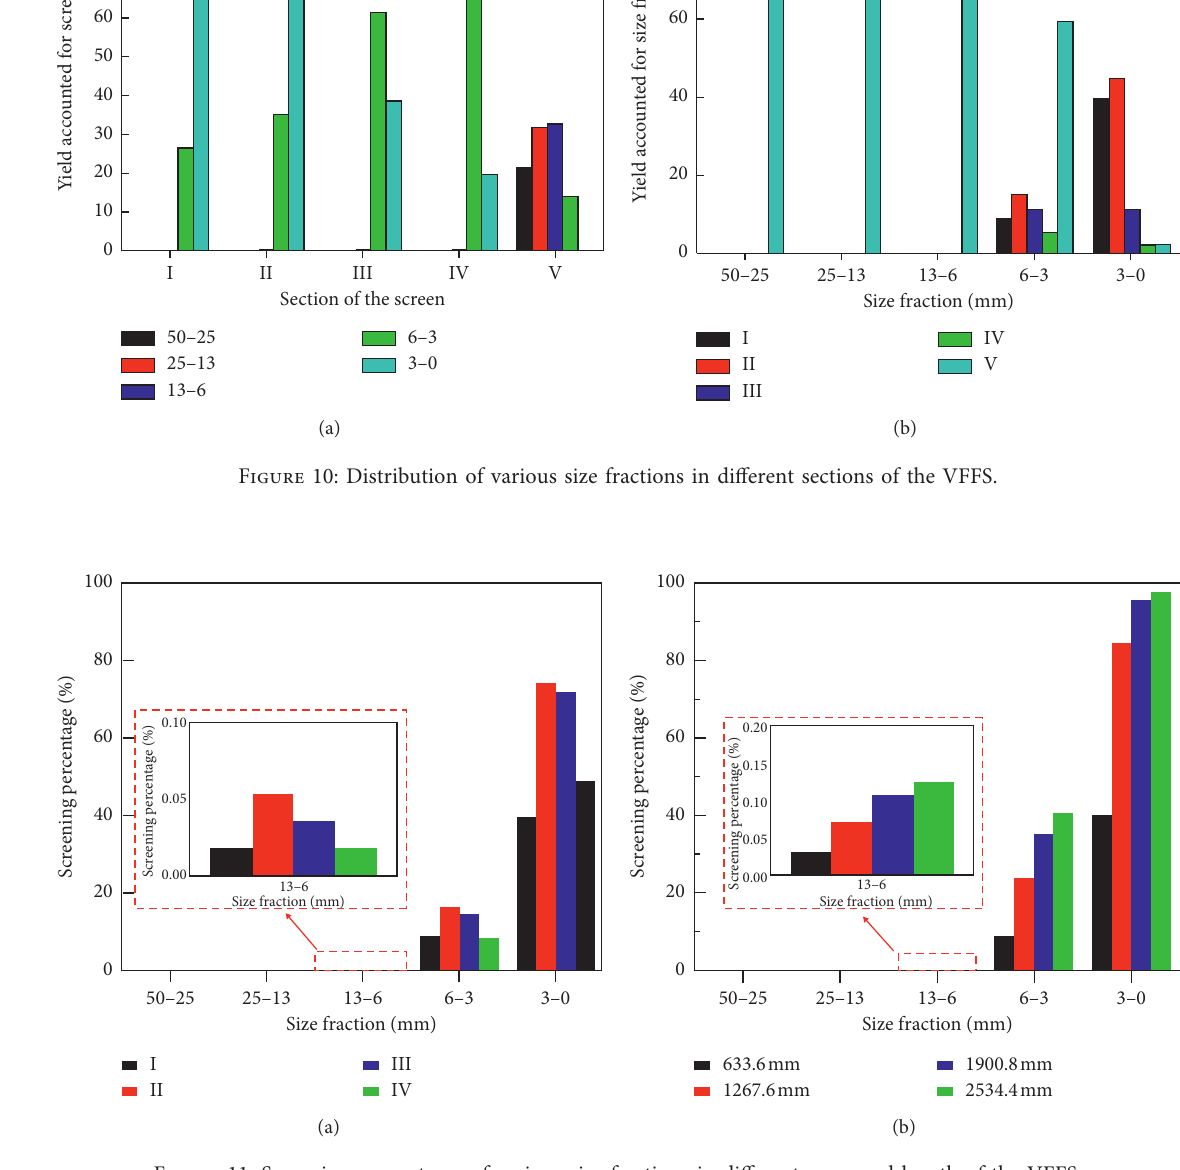
Figure 11: Screening percentages of various size fractions in different areas and length of the